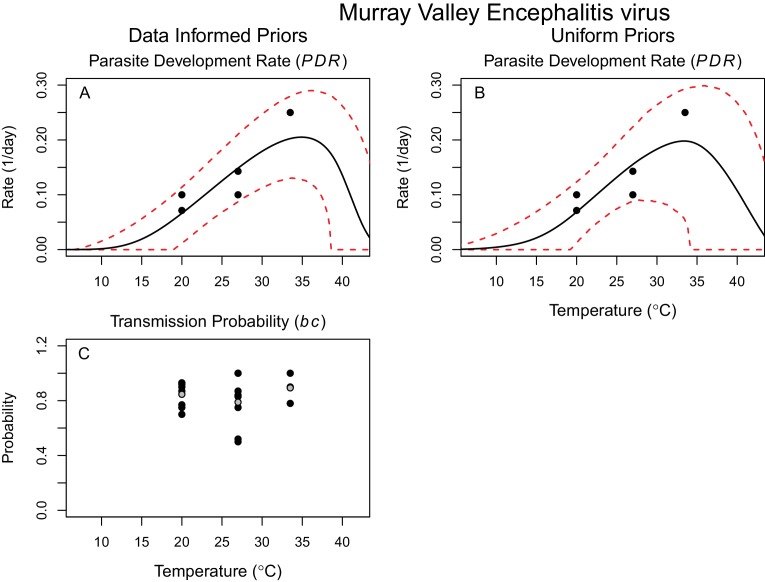
Thermal responses of Murray Valley Encephalitis virus.